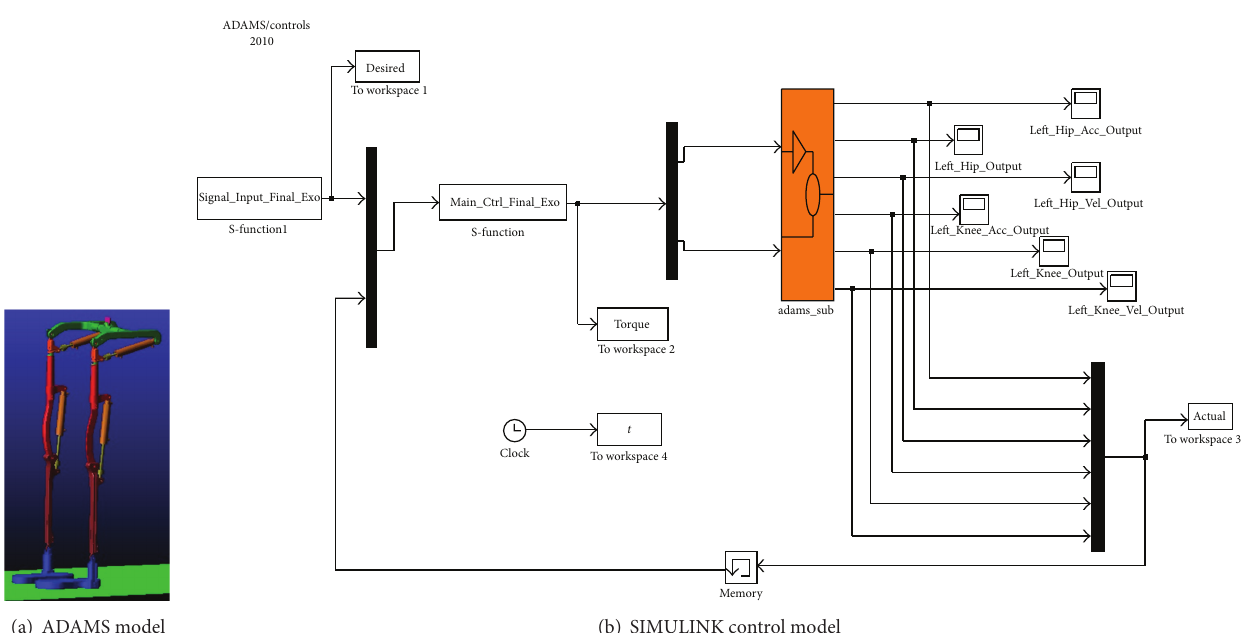
Figure 6: Cosimulation using ADAMS and MATLAB for exoskeleton robot.